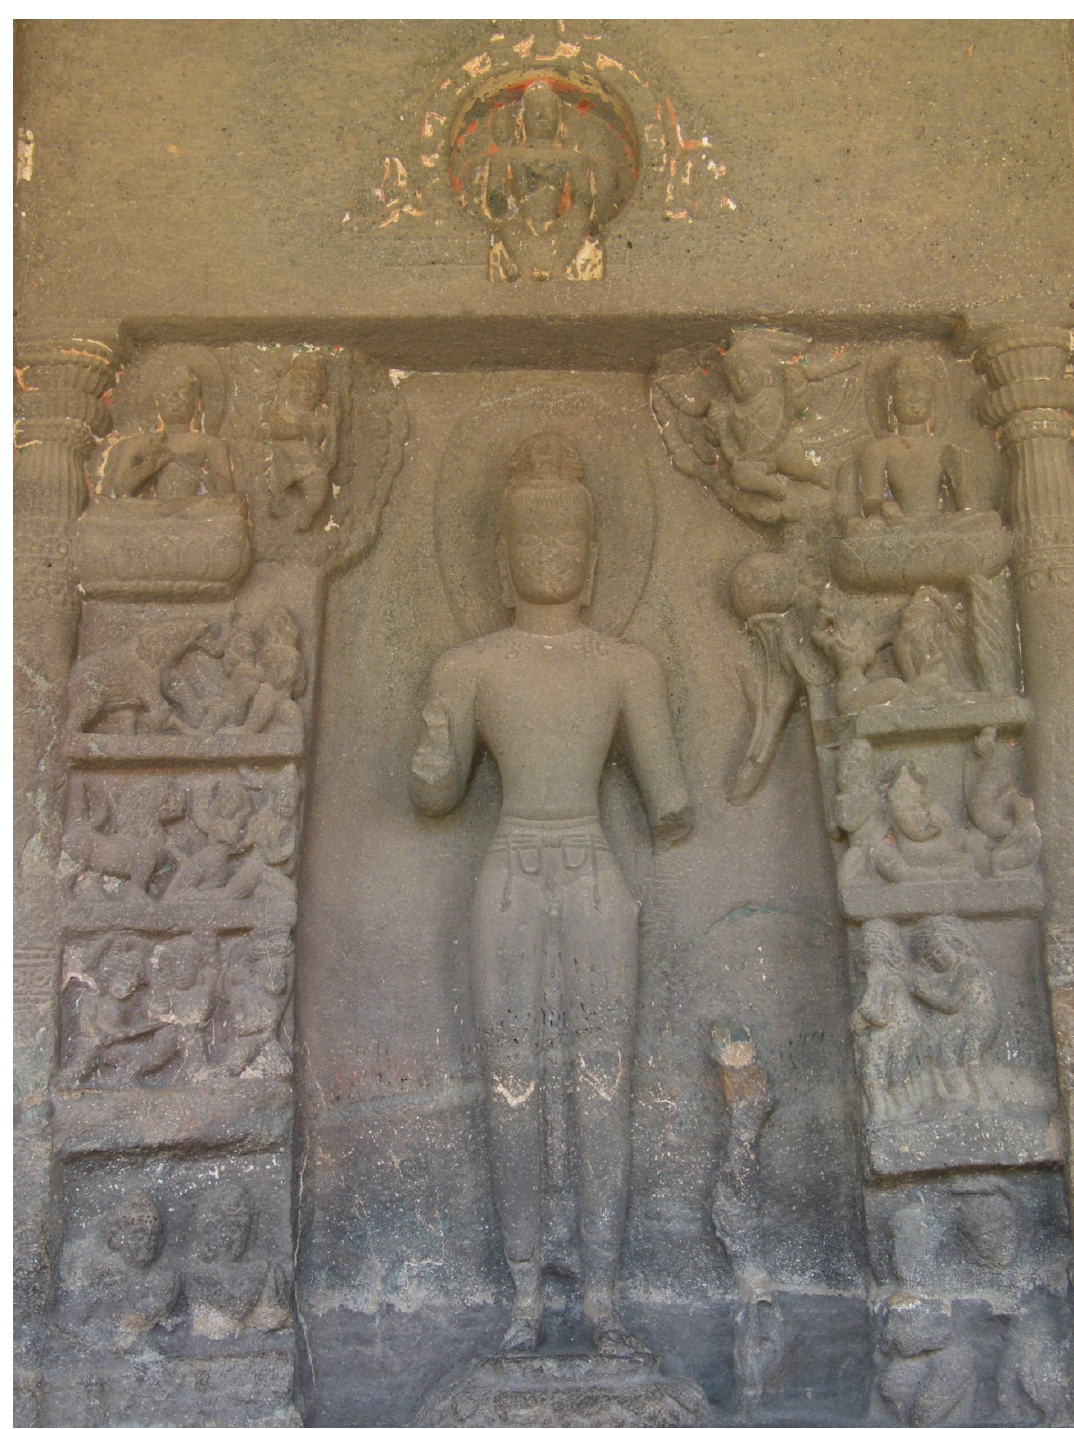
Figure 14. Intrusive panel depicting the “Litany of Avalokite ś vara” from Aja ṇṭ ā Cave 4 (porch), ca. 478–480 CE (Photograph by the author).